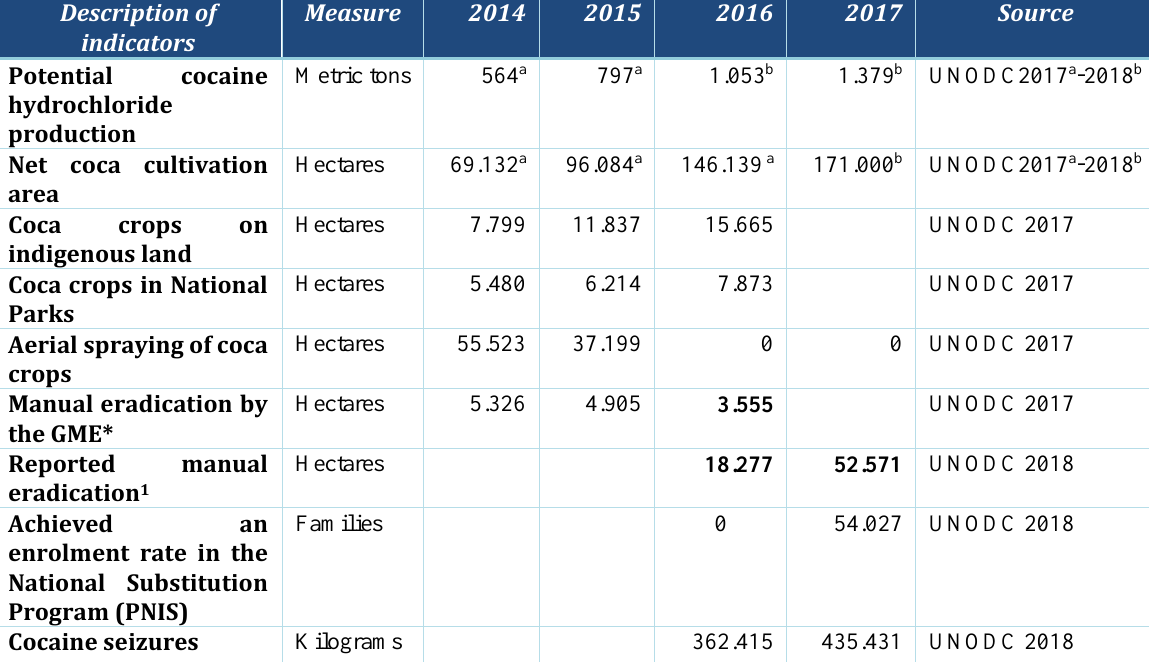
Table 1: Summary of indicators according to the UNODC coca surveys 2017–2018 before and after signing the JDI—Paris 2015 and the peace agreement between the Colombian government and FARC in 2016 (Oficina del alto comisionado para la paz